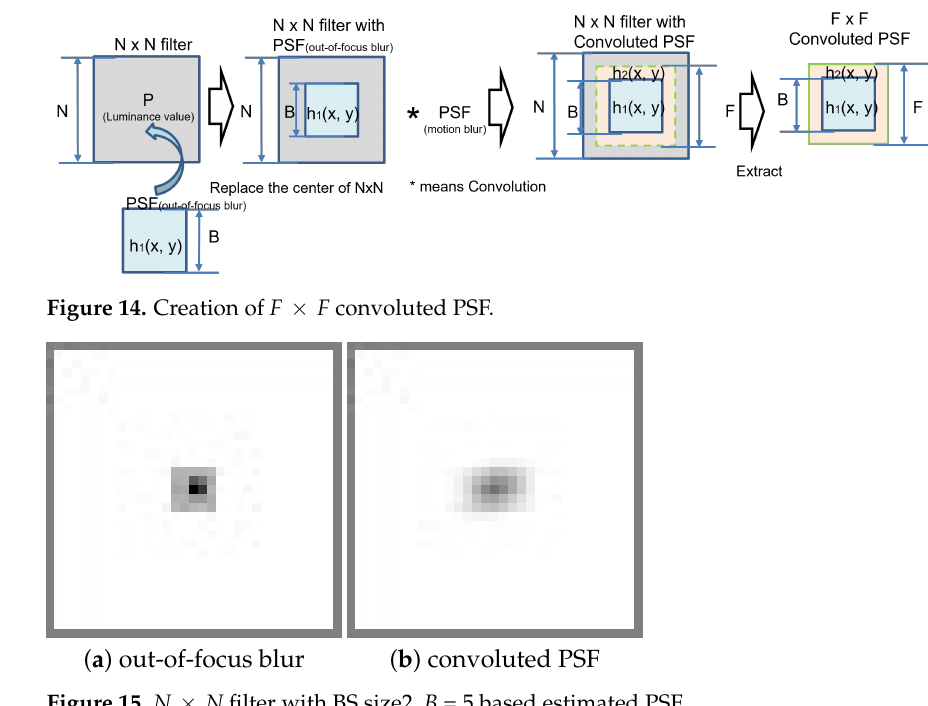
Figure 15. N × N filter with BS size2, B = 5 based estimated